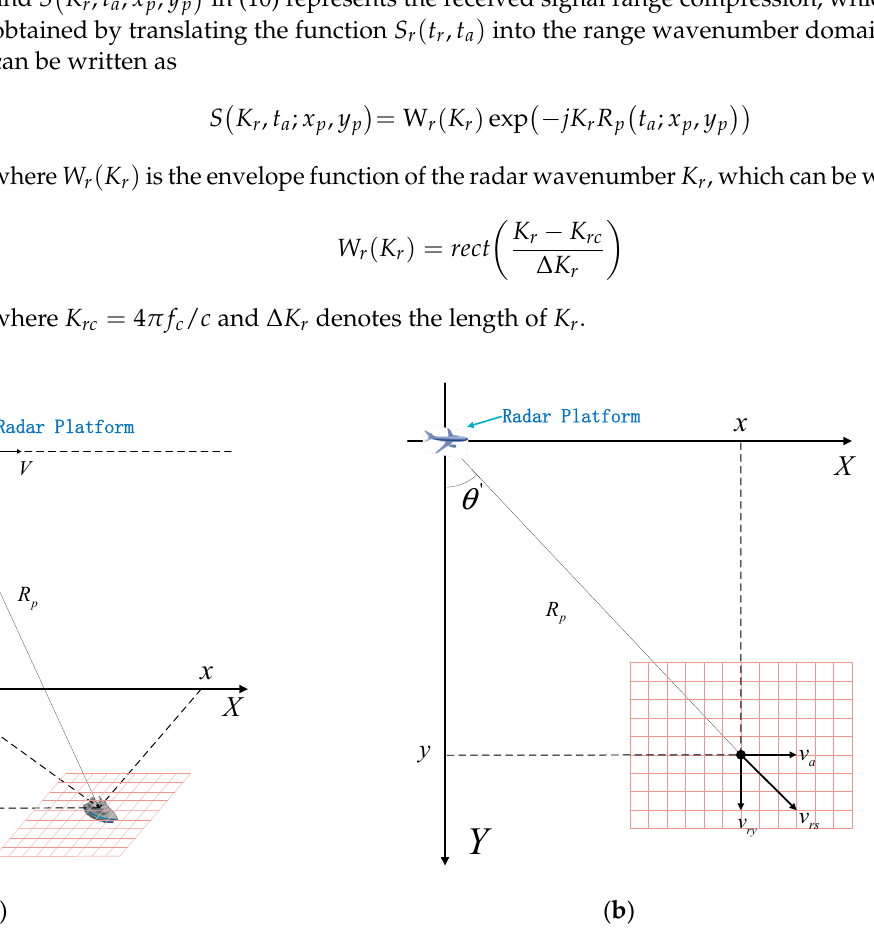
Figure 2. Imaging grid model of squint SAR: ( a ) Imaging grid model in the squint SAR geometry; ( b ) The top view of the imaging grid.